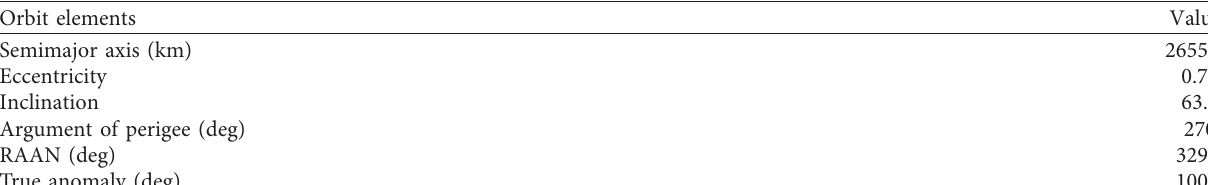
Table 1: Orbit elements of the target spacecraft.